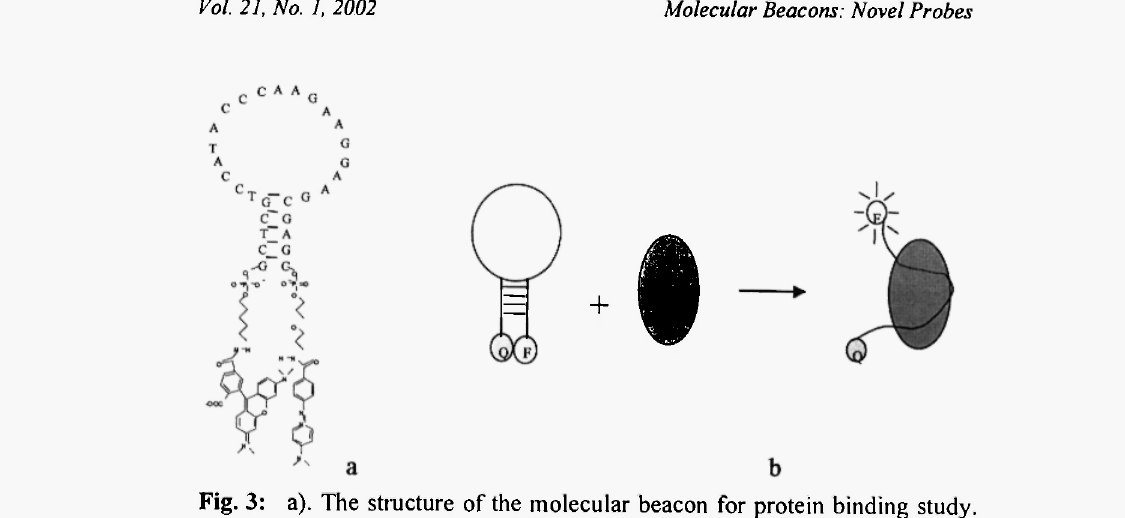
Fig. 3: a). The structure of the molecular beacon for protein binding study, b). Schematic mechanism of the operation of molecular beacon. On its own, the MB is non-fluorescent, since the stem keeps the fluorophore close to the quencher. Molecular beacon emits intense fluorescence only when its stem is opened through the binding to SSB. Reprinted from reference 16 with permission.